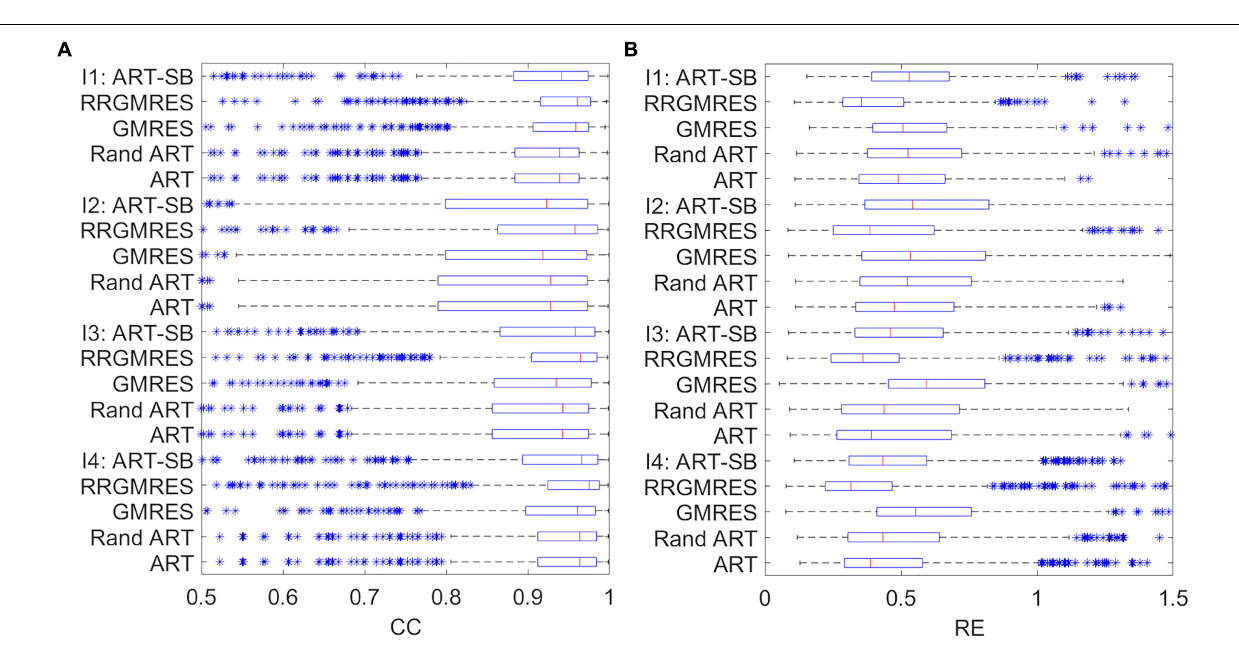
FIGURE 5 | Boxplots showing the mean, the distribution, the standard deviation (“whiskers”) and the outliers (“*”), for: (A) CC and (B) RE. Y -axis show the reconstruction method used for each one of the four ischemia recordings of the Utah dataset (I1, I2, I3,